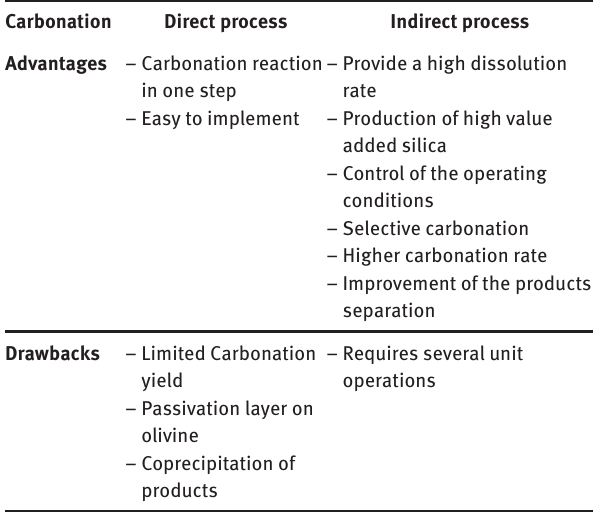
Table 4: Comparison between direct and indirect carbonation